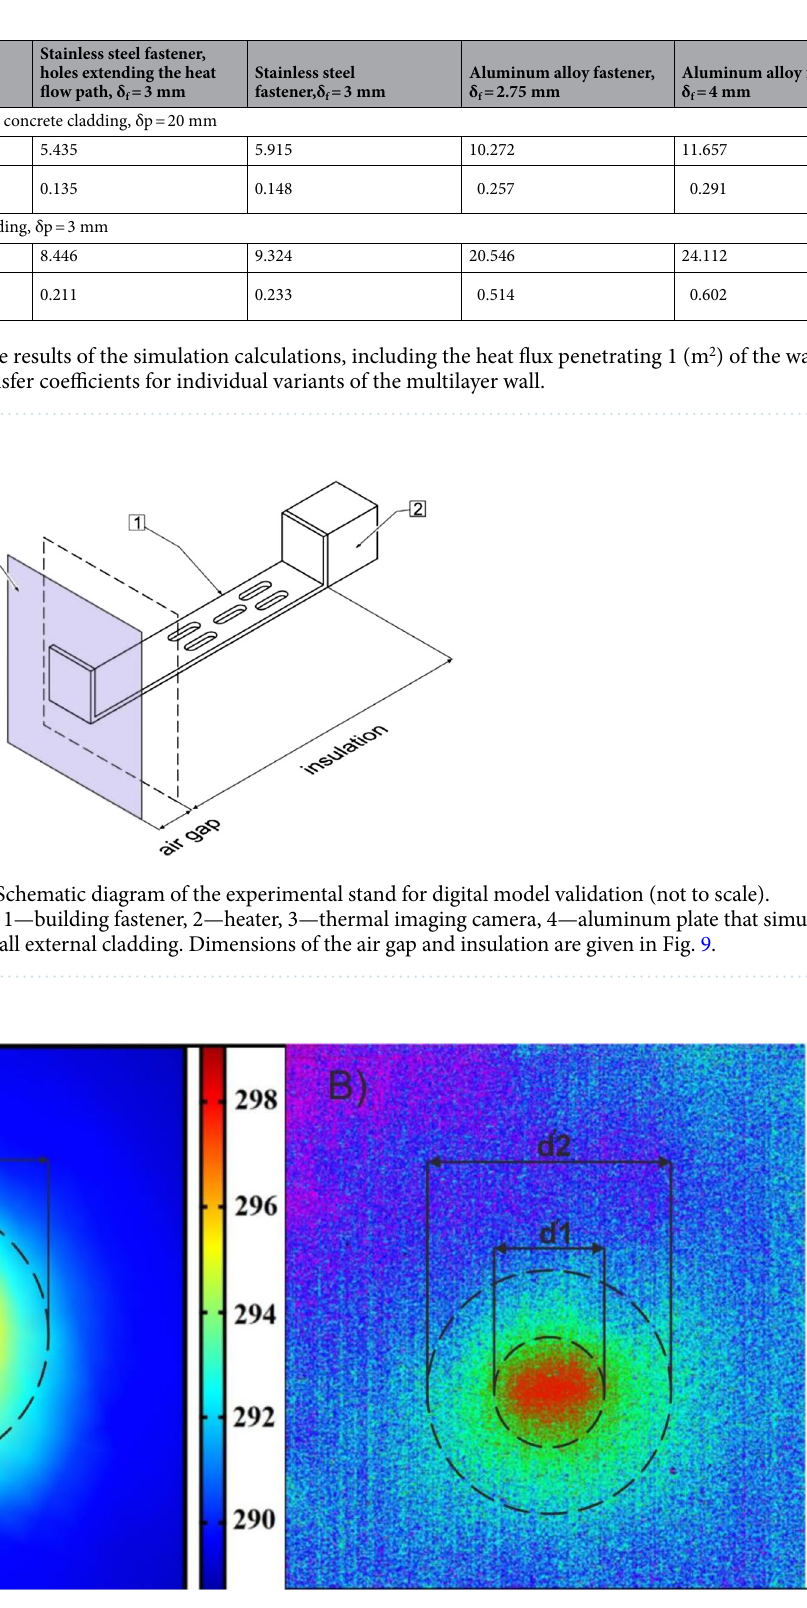
Figure 13. Temperature distribution around the interface between the fastener and the cladding at the conditions simulating natural temperatures of both elements: ( A ) numerical simulation, ( B ) recorded with thermal imaging camera. The temperature means were evaluated along the circles with diameters d 1 and d 2